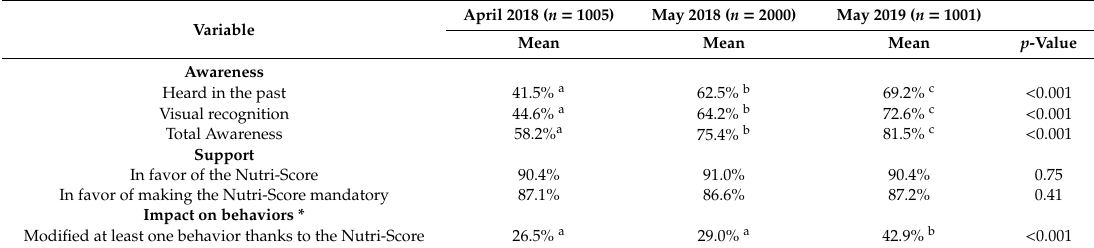
Table 2. Evolution of awareness, support, and purchasing behaviors across the three successive